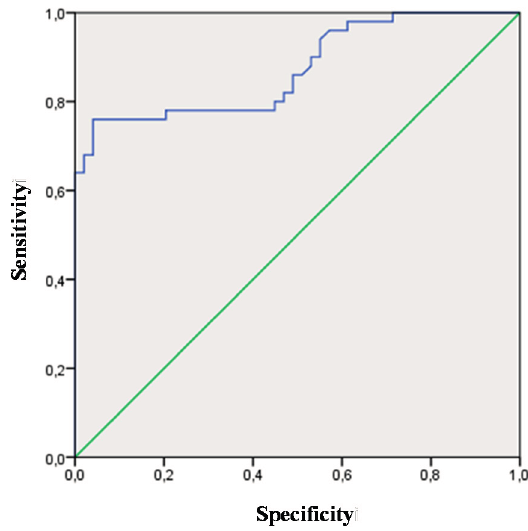
Figure 2. ROC for the NT-proBNP variable (AUC 0.873; p = 0.0001; 95% CI (0.803–0.943)) revealing its diagnostic potential for HF.